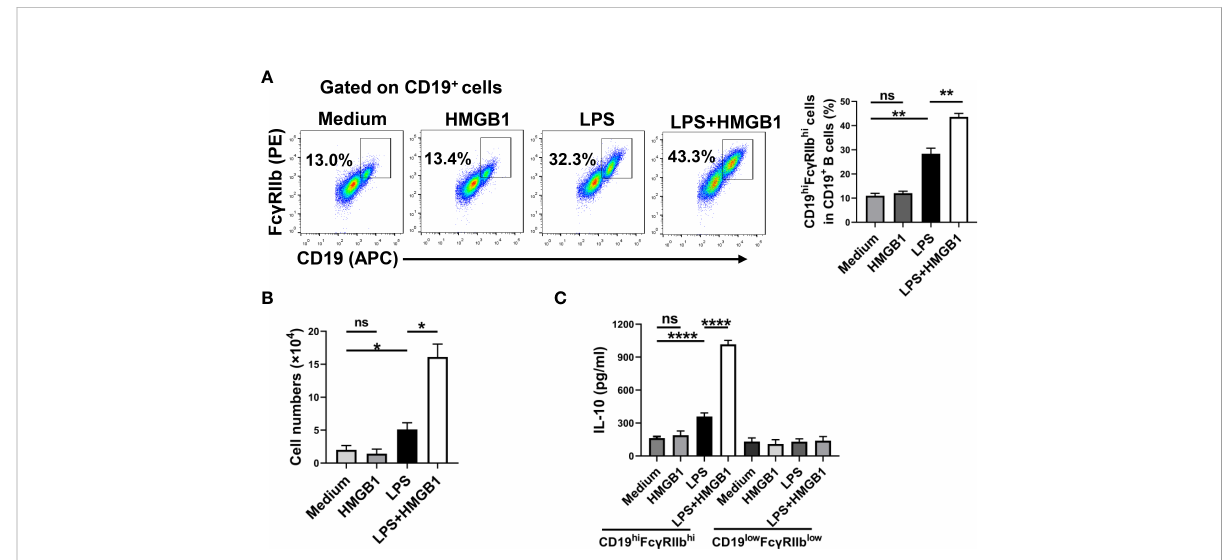
FIGURE 4 HMGB1 promotes the expansion and IL-10 secretion of CD19 hi Fc g RIIb hi B cells in vitro . Sorted CD19 + B cells (2 × 10 5 /well) from C57BL/6 mice were cultured with HMGB1 (10 m g/mL) and LPS (500 ng/mL) for 2 days. (A, B) Flow cytometry was performed to assess the percentage (A) and number (B) of CD19 hi Fc g RIIb hi B cells. Data are shown as means ± SEMs of three independent experiments. (C) CD19 hi Fc g RIIb hi B cells and CD19 low Fc g RIIb low B cells were sorted by fl ow cytometry. CD19 hi Fc g RIIb hi B cells or CD19 low Fc g RIIb low B cells (2 × 10 5 ) were plated on 96-well plates for 24 h. IL-10 secretion by CD19 hi Fc g RIIb hi B cells was analyzed by ELISA. Data are shown as means ± SEMs of four independent experiments. *P < 0.05; **P < 0.01; ****P <0.0001; NS, not signi fi